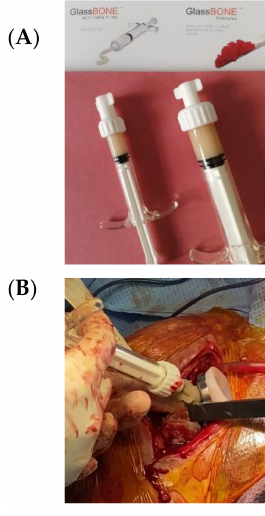
Figure 1. ( A ) The bone substitute GlassBONE, made of bioactive glass. ( B ) Ready-to-use, it can be injected through the syringe directly into the bone defect or onto the bone-prosthesis